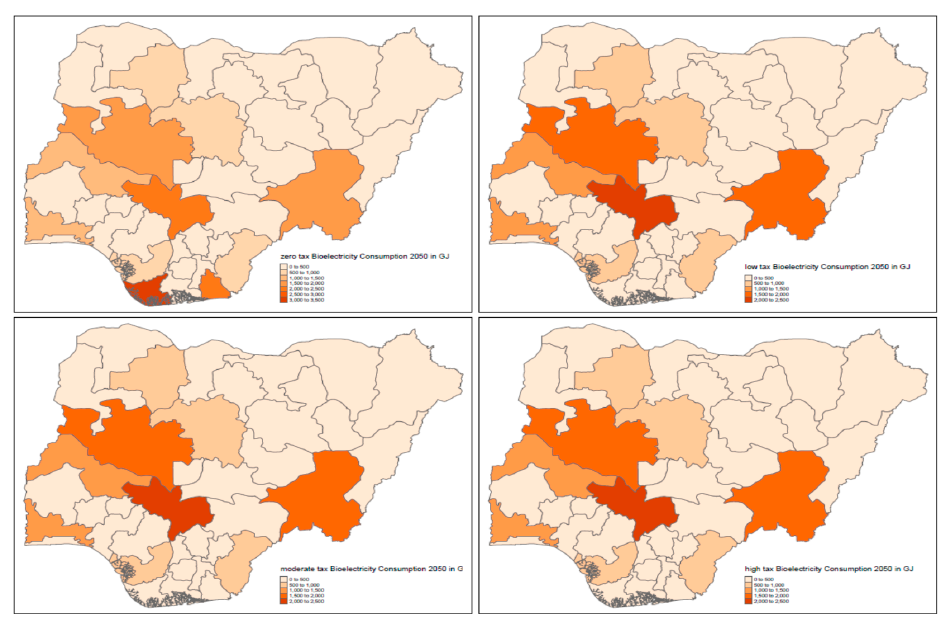
Figure 12. Bioelectricity consumption by 2050 under subsidy action.